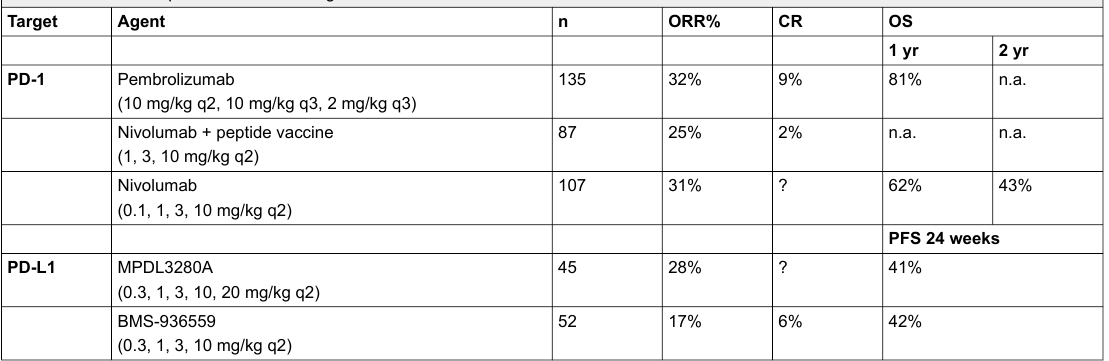
Table 1: Overview of phase I trials including anti-PD-1 or -PD-L1 monoclonal antibodies in metastatic melanoma.